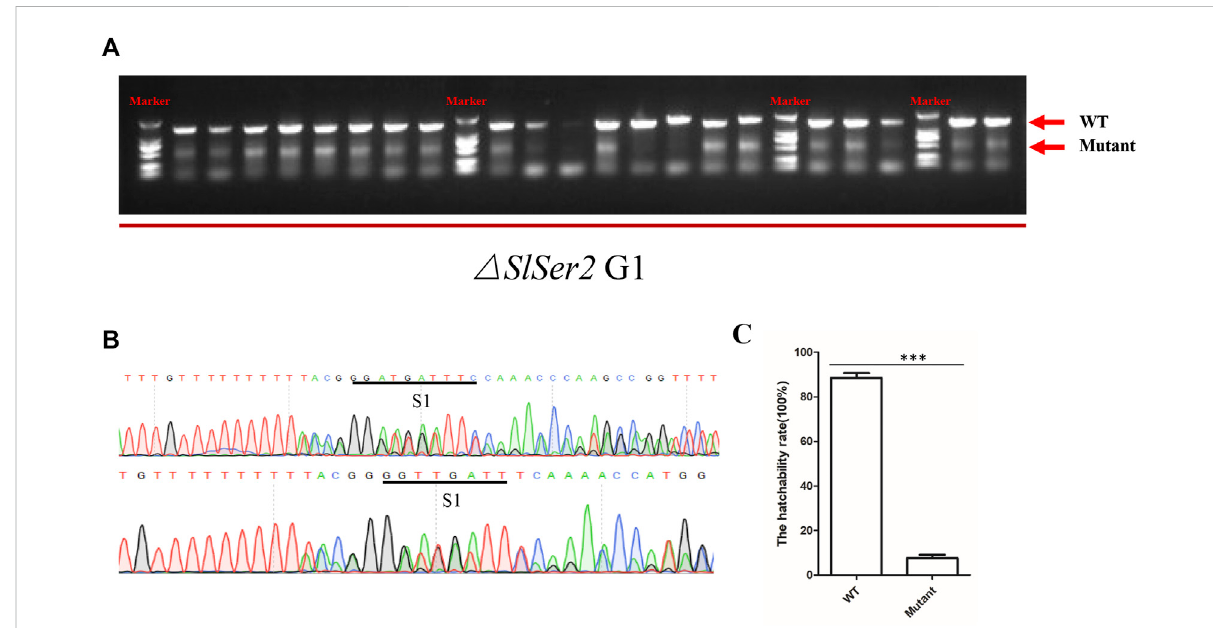
FIGURE 4 Male sterility is heritable stably in the next generation. (A) The PCR detection of mutations in G1 adult males. Arrows indicate band sizes. The upper major band is WT. Different size bands appear in each sample due to induction of different deletions and chimerism. (B) Representative sequencing chromatograms of PCR products of chimeric mutants. The bottom chromatogram shows peaks with multiple nucleotides at some positions (S1),indicating theoccurrenceofmutantandwildtypesequencesatthesameloci. (C) TheoffspringhatchabilityrateofG1male adult mutants. The data shown are means ± S.E.M. Asterisks indicate signi fi cant differences with a two-tailed t -test: *** p < 0.001.